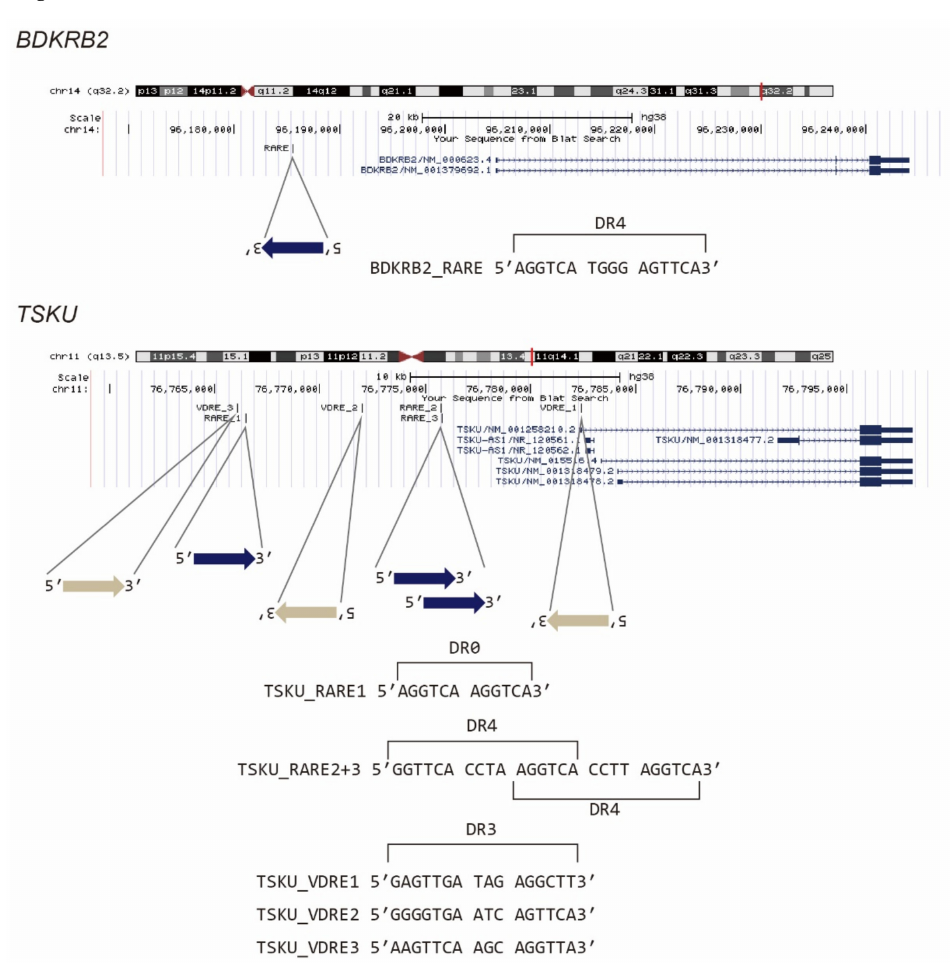
Figure 3. Presumed vitamin-responsive genomic sequences of BDKRB2 and TSKU . The known consensus sequences of RARE or VDRE were searched in a promoter area of about 20 kb, and the position of the hit sequence was mapped using the UCSC genome